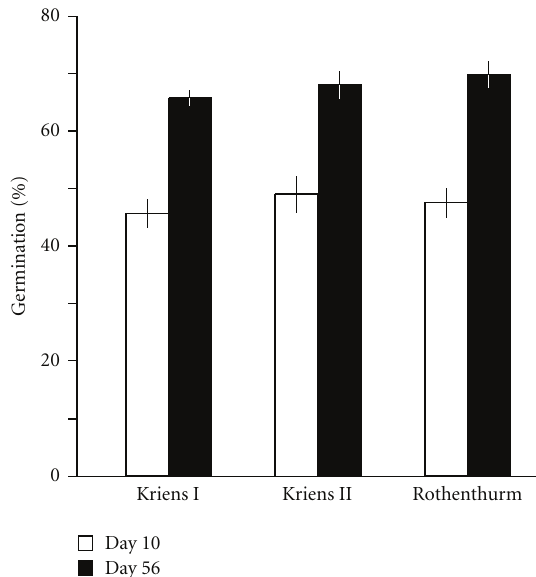
Figure 2: Germination percentages of fresh ripe seeds of Senecio aquaticus sampled in 2008. Displayed are means ± SE ( n = 10) at day 10 and day 56 of an eight-week germination period. For germination, seeds were mixed with substrate that was thoroughly crumbled twice to provide light to all